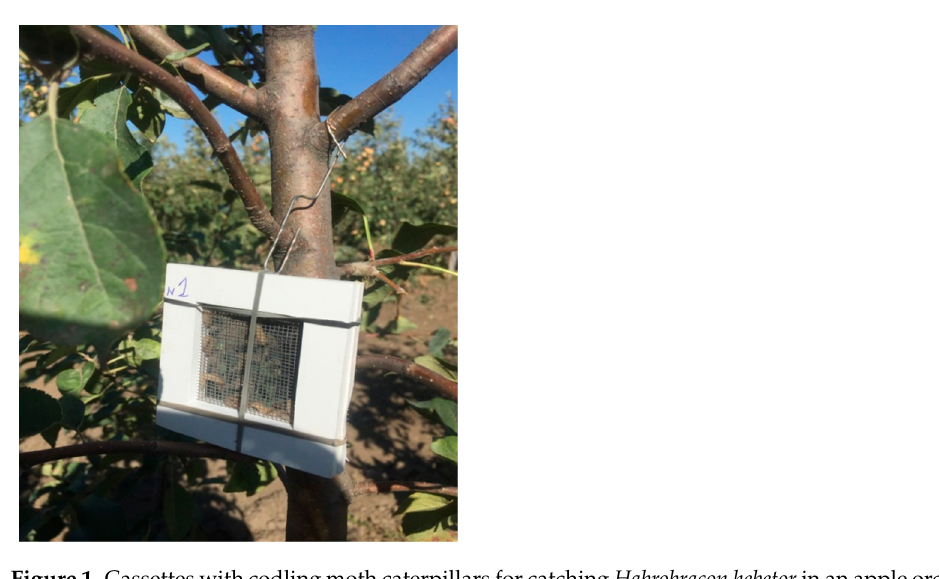
Figure 1. Casse tt es with codling moth caterpillars for catching Habrobracon hebetor in an apple or- chard